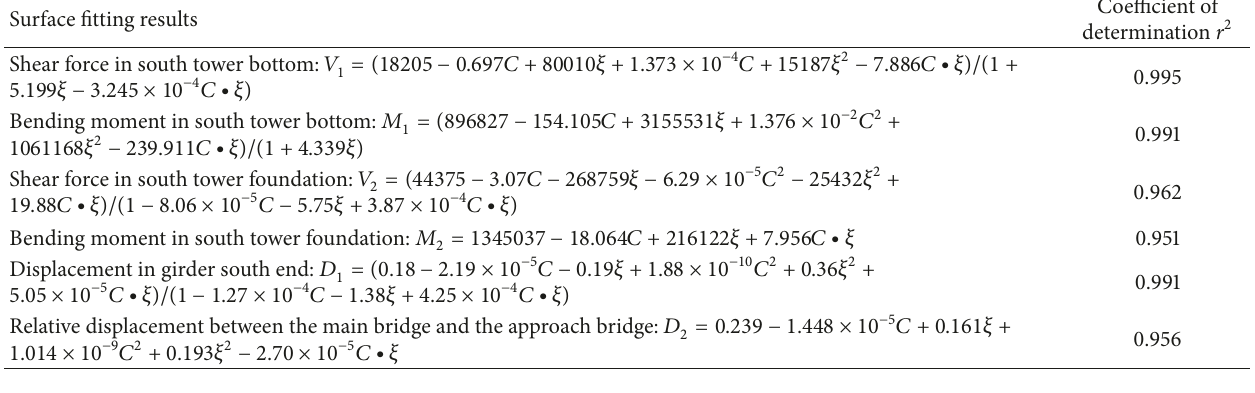
Table 1: Parametric regression analysis.